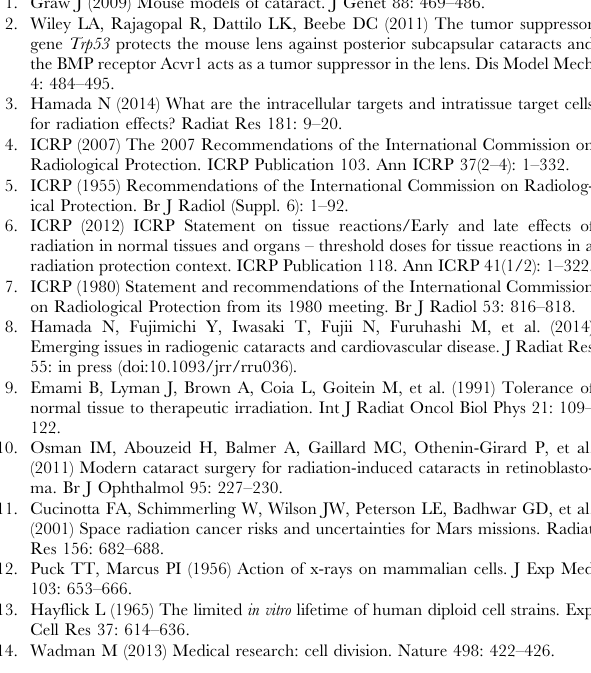
Figure S2 The frequency distribution of area of clono- genic colonies arising from HLEC1 and WI-38. (TIF) Figure S3 The fraction of clonogenic colonies exceeding the mean + 2SD area of sham-irradiated controls among all plated cells. (TIF) Figure S4 Methods used to evaluate cell numbers in each clonogenic colony arising from HLEC1. (TIF) Figure S5 The integrated density of clonogenic colonies arising from HLEC1 and WI-38. (TIF) Figure S6 The relationship between the integrated density and cell numbers in all countable clonogenic colonies arising from HLEC1. (TIF) Figure S7 Alterations in the distribution of colonies in HLEC1 and AG01522D. (TIF) Table S1 Number of cells replated per 10-cm dish after irradiation for colony formation.